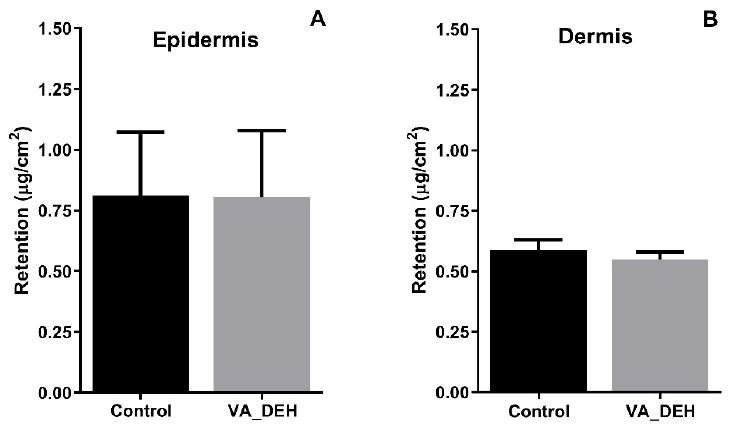
Figure 6. Amount of chlorogenic acid retained in ( A ) epidermis and ( B ) dermis after 24 h of in vitro permeation and retention study (mean ± SD). Welch’s t test showed no statistical difference.